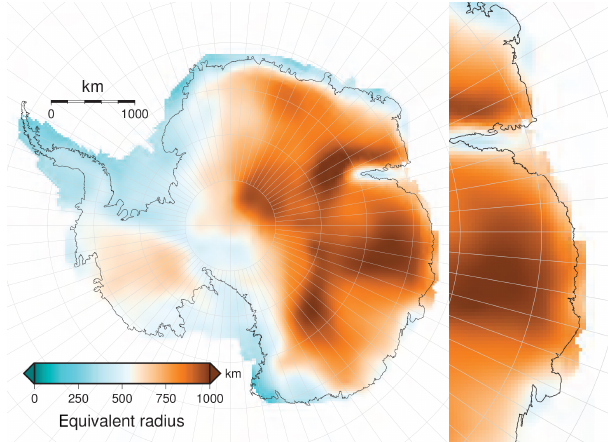
Figure 4. A spatial plot of the areal extent that a temperature record is representative of, calculated from ERA-Interim surface (2m) temperature. Equivalent radius is the correlation length, i.e. the dis- tance from a given point, with which surface temperature is highly correlated ( > 0.7). The right-hand panel is the enlarged coastal East Antarctic sector.